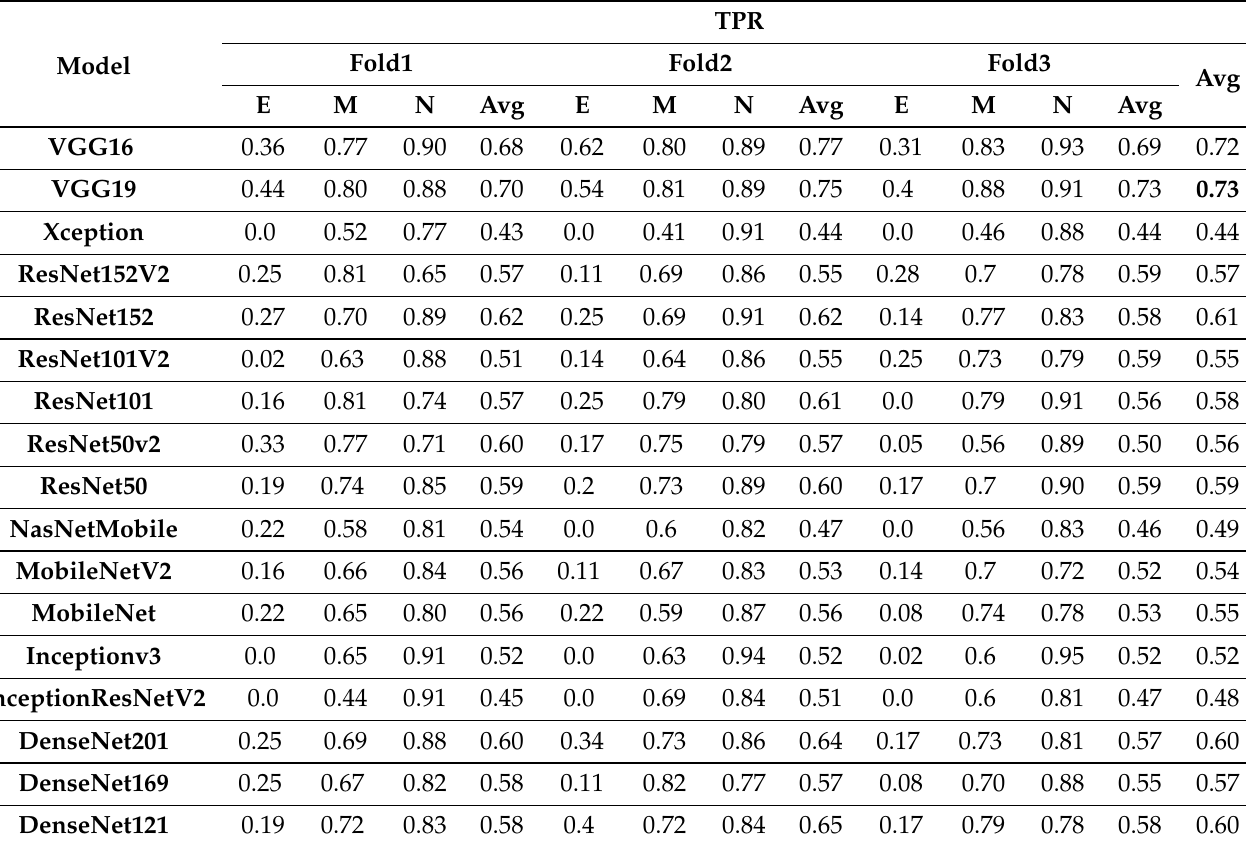
Figure 9. Overview of CNN models average training time vs average validation accuracy without selection process. Table 5. Validation true positive rate (TPR) of CNN models using 3 classes (E: Extrasystole; M: Murmur; N: Normal) and 3 folds without selection